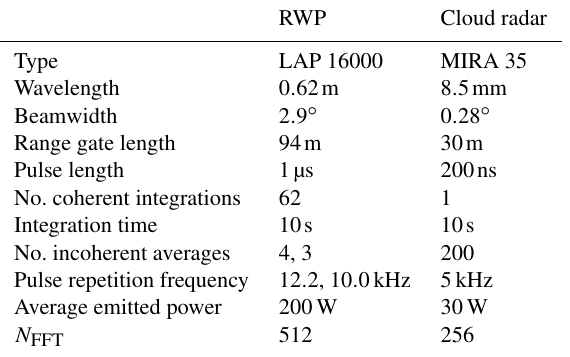
Table 1. Configuration settings of the major instruments used in the COLRAWI campaigns (based on Bühl et al., 2015). The second number indicates the setting used for the RWP during IOPs.